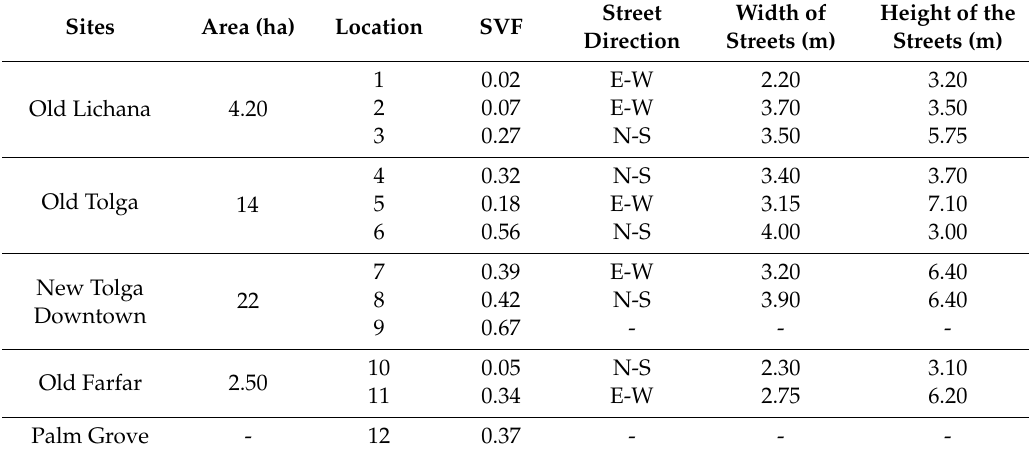
Table 1. Morphological characteristics of sites and measurement points in Tolga Oasis Complex, July and August 2018.